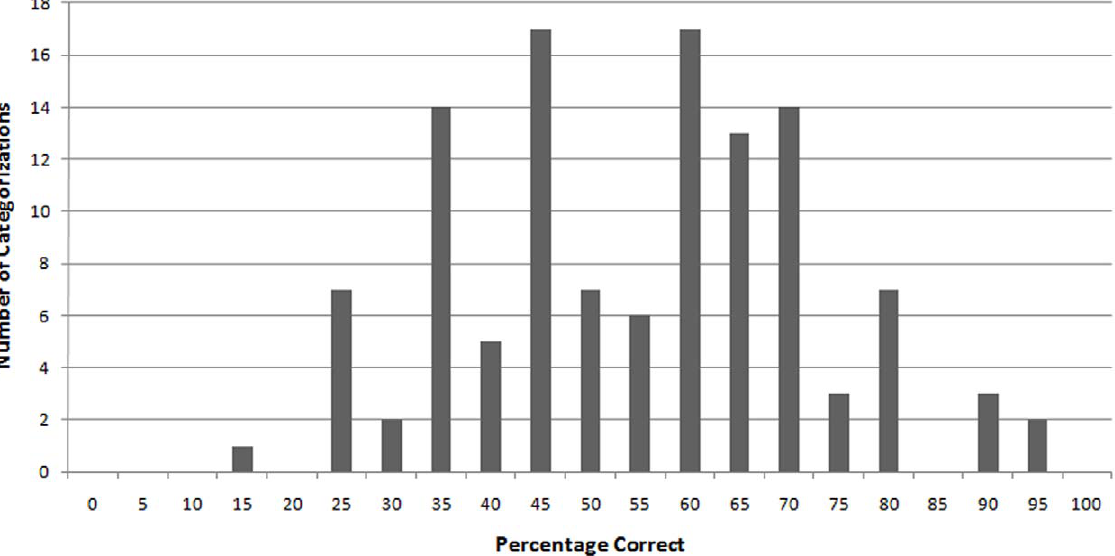
Figure 1. Frequency of accurate categorizations of targets as Democrats and Republicans in Study 1 according to 5% bins.